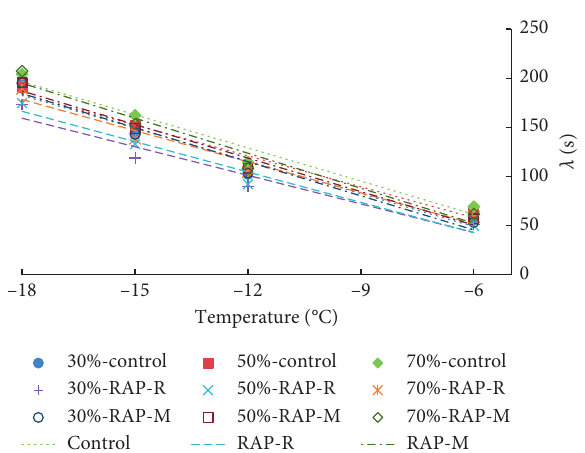
Figure 16: Relationship of relaxation time λ and temperature.